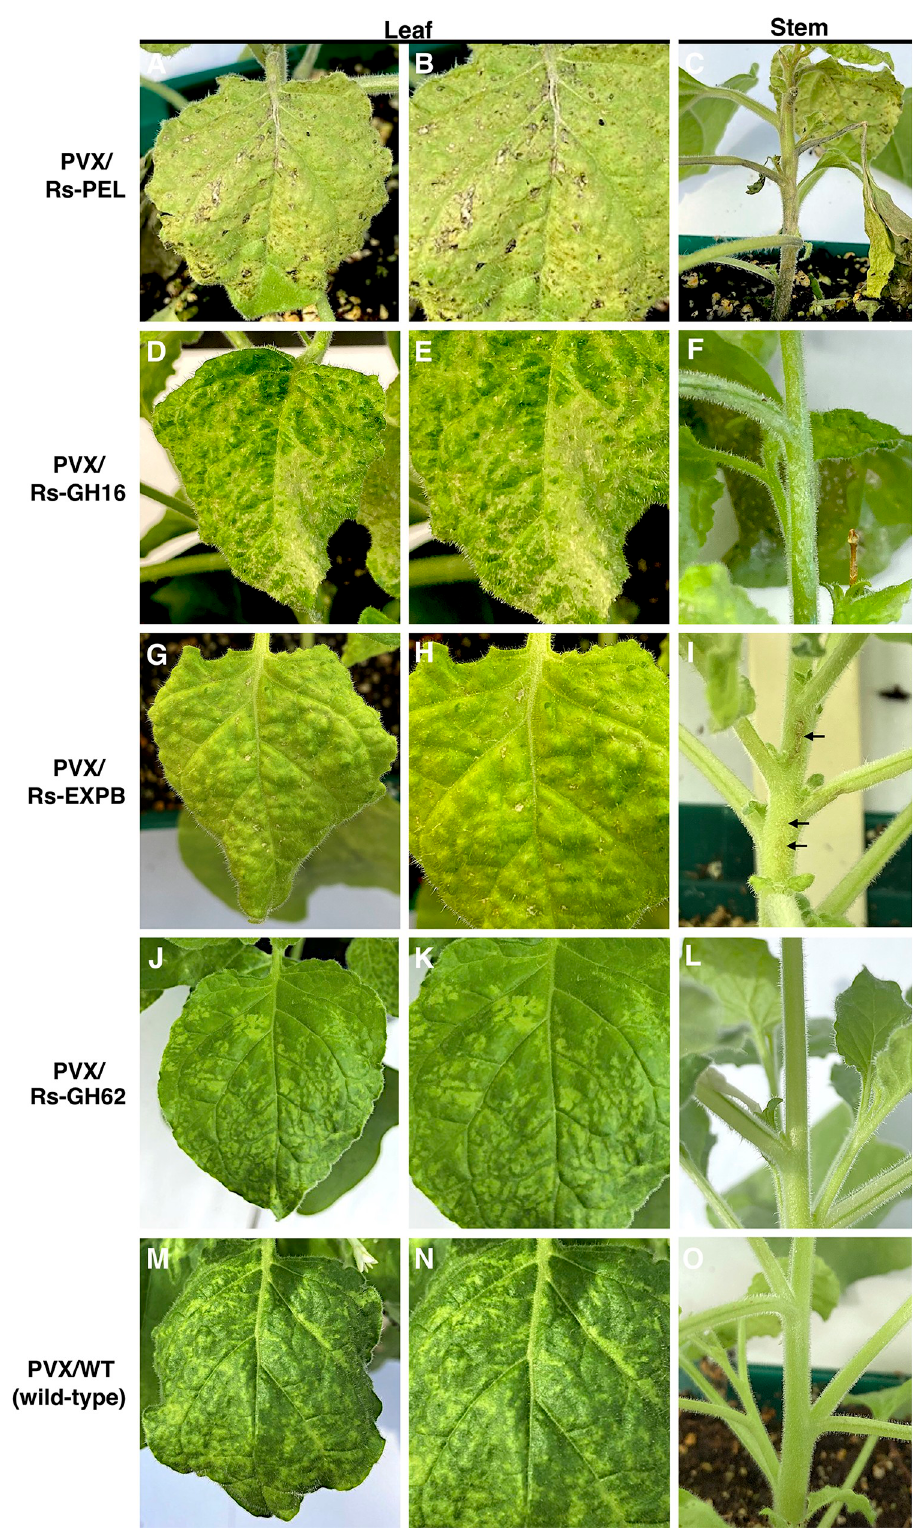
Fig 9. Phenotypic changes in Nicotiana benthamiana plants infected with recombinant potato virus X carrying cell wall-modifying genes of Radopholus similis . (A-C) Expression of Rs-PEL gene induced large necrotic lesion